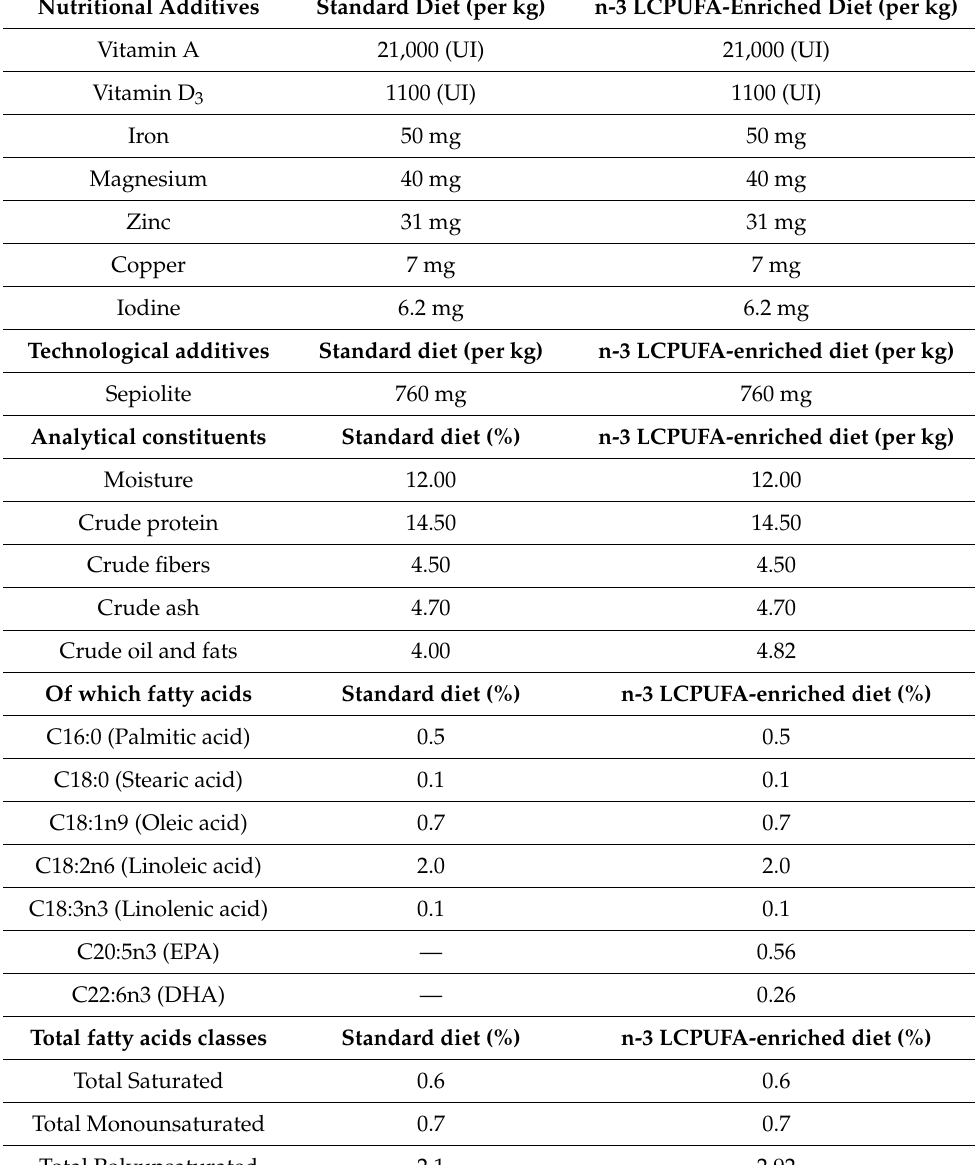
Table 2. Nutritive content of the standard and n-3 LCPUFA-enriched